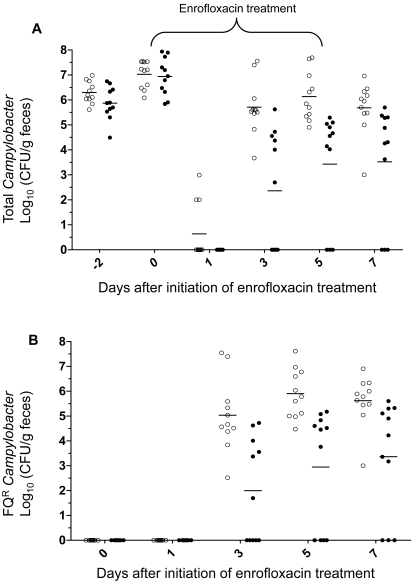
Development of FQR
Campylobacter mutants in chickens initially infected with FQ-susceptible Campylobacter, but treated with enrofloxacin.(A) The level of total Campylobacter in each chicken inoculated with the wild-type 11168 (open circle) or the mfd mutant strain (JH01; solid circle). The treatment with enrofloxacin started on day 0 and lasted for five consecutive days (indicated by a bracket on top of the panel). (B) The level of FQR
Campylobacter in each chicken inoculated with the wild-type (open circle) or the mfd mutant (solid circle). In both panels, each symbol represents the number of Campylobacter in a single bird. Each group includes eleven chickens and the mean of each group at a given time is indicated by a horizontal bar. A chicken is considered negative if the level of colonization was below the detection limit (102 CFU/ g of feces).